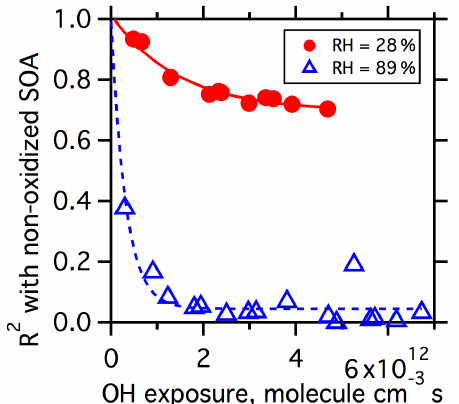
Figure 5. Coefficient of determination ( R 2 ) between spectra of ox- idized SOA and nonoxidized SOA as a function of OH exposure for dry (red circles) and wet (blue triangles) conditions. Spectra are filtered by excluding ions that have a percentage contribution to the total signal below 0.5%. Lines are exponential fits and presented only as visual